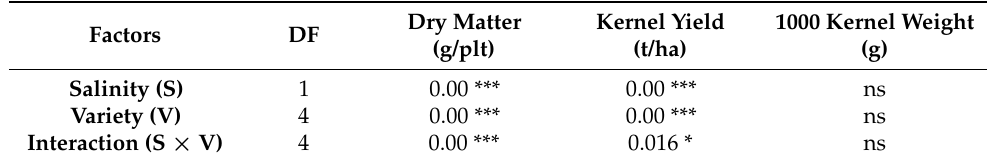
Table 2. Analysis of variance (GLM procedure) of the effect of salinity, variety and their interaction on post harvesting